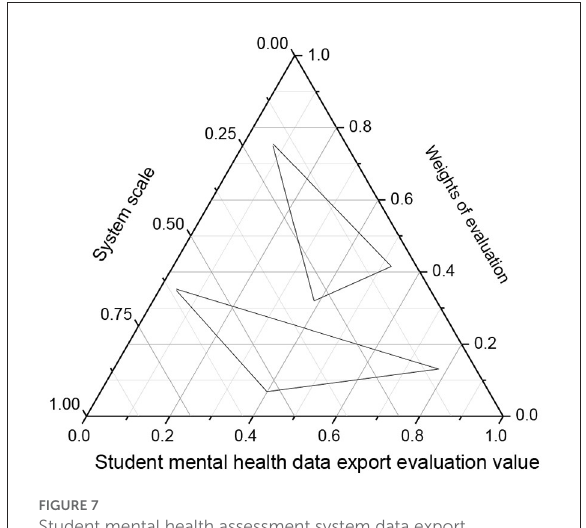
FIGURE7 Student mental health assessment system data export